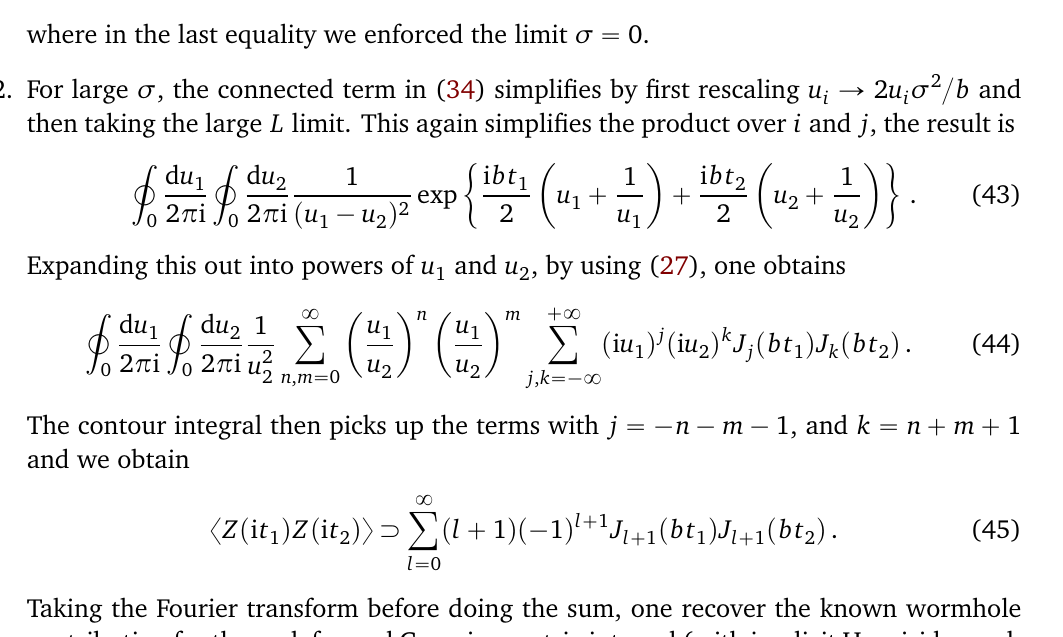
q (bot- , E 1 2 q is only , E 1 2 where it 0 q has a quadratic , E 1 2